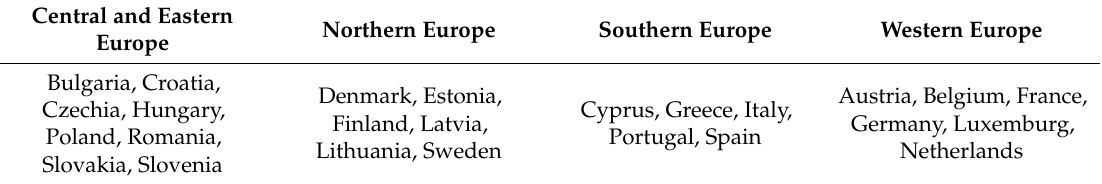
Table 8. Non-English speaking Countries divided to four European Regions as defined by EuroVoc. Central and Eastern